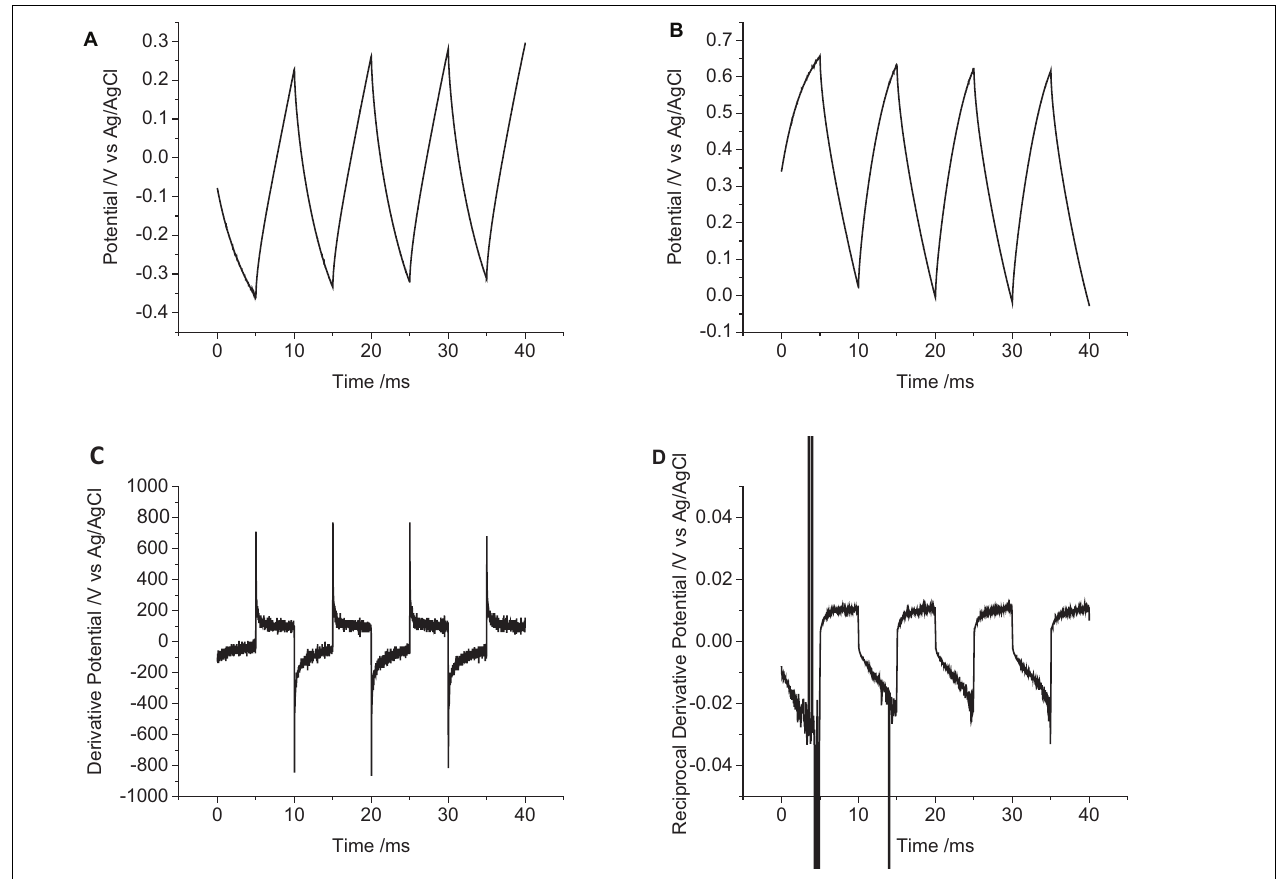
FIGURE 8 | Multiple pulse chronopotentiometry of a non-polished cochlear implant platinum electrode (0.3 mm 2 nominal area) in degassed artificial perilymph. (A) Cathodic, (B) anodic pulse first with a current density of 10 µ C cm − 2 . (C) Derivative and (D) reciprocal derivative of curve (A)